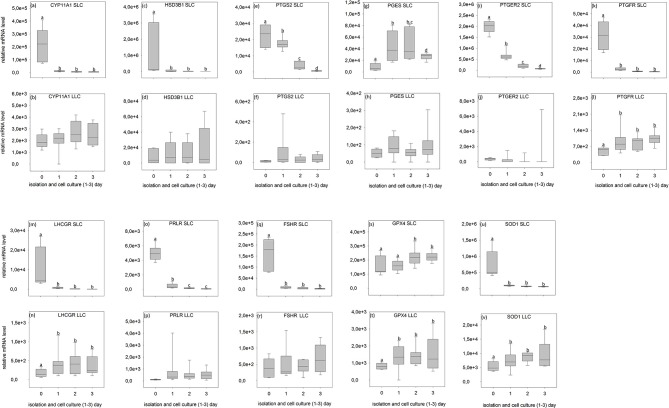
Relative mRNA level of analyzed genes in SLC (small luteal cells) and LLC (large luteal cells) obtained directly after isolation (Day 0) and after 1–3 days of culture (Experiment A). (a,b)
CYP11A1, Cholesterol Side-Chain Cleavage Enzyme, (c,d)
HSD3B1, 3β-hydroxysteroid dehydrogenase type 1, (e,f)
PTGS2, prostaglandin-endoperoxide Synthase 2, (g,h)
PGES- Prostaglandin E synthase, (i,j)
PTGER2, prostaglandin E receptor 2, (k,l)
PTGFR, prostaglandin F receptor, (m,n)
LHCGR, luteinizing hormone/choriogonadotropin receptor, (o,p)
PRLR, prolactin receptor, (q,r)
FSHR, follicle stimulating hormone receptor, (s,t)
GPX4, glutathione peroxidase 4, (u,v)
SOD1, superoxide dismutase 1. Small letters indicate significant differences between groups, based on pairwise comparison Wilcoxon rank sum test.